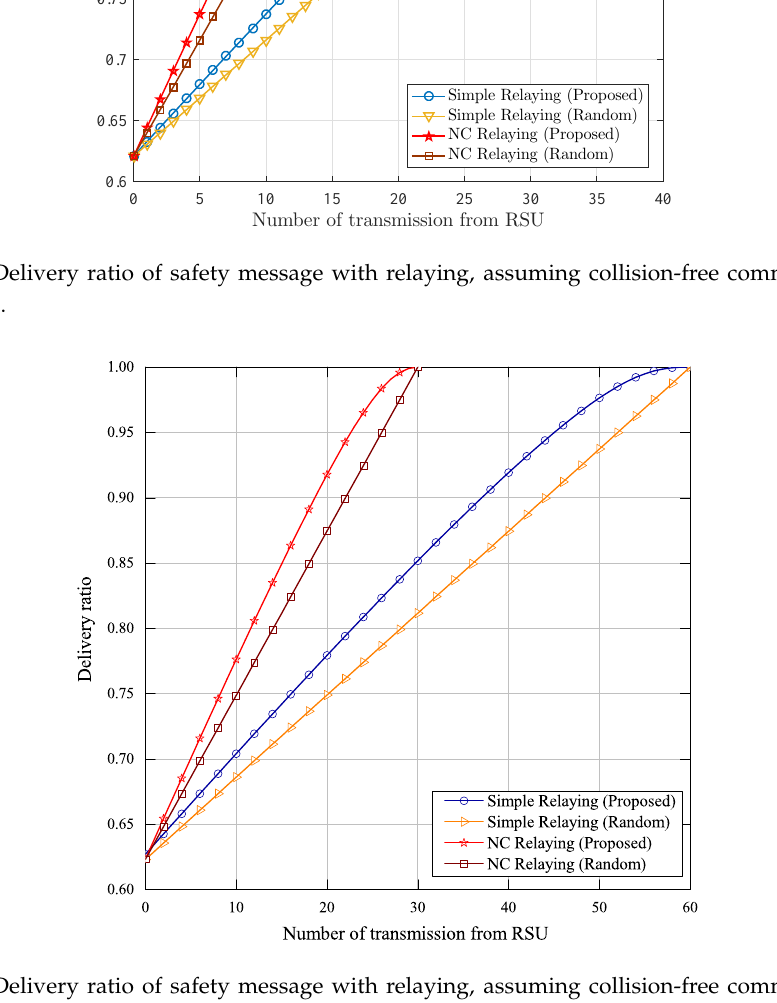
Figure 5. Delivery ratio of safety message with relaying, assuming collision-free communication (for N =